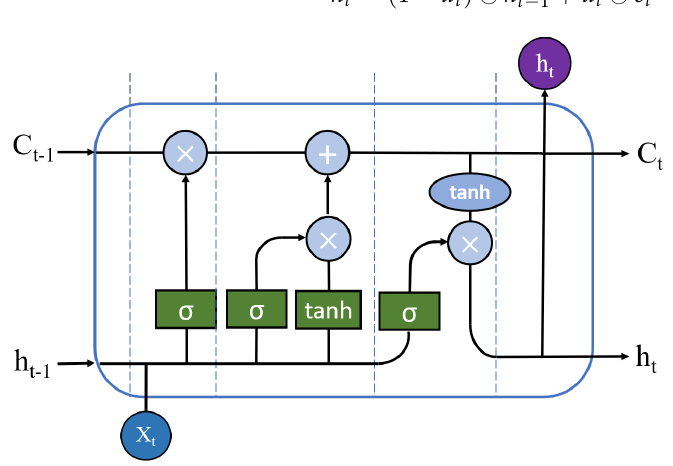
Figure 5. Long short-term memory (LSTM).